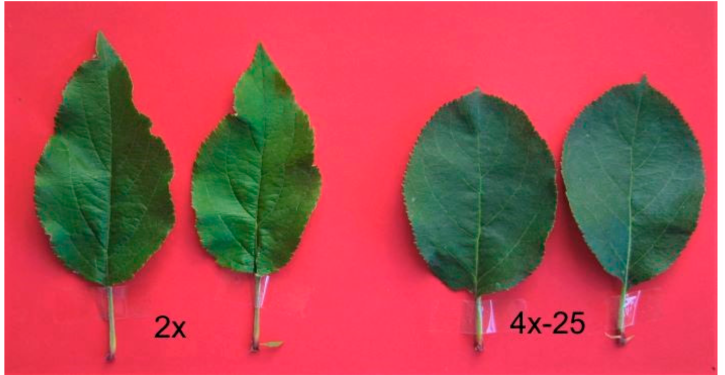
Figure 3. Leaves of diploid and tetraploid clone 4x-25 of the apple cv.